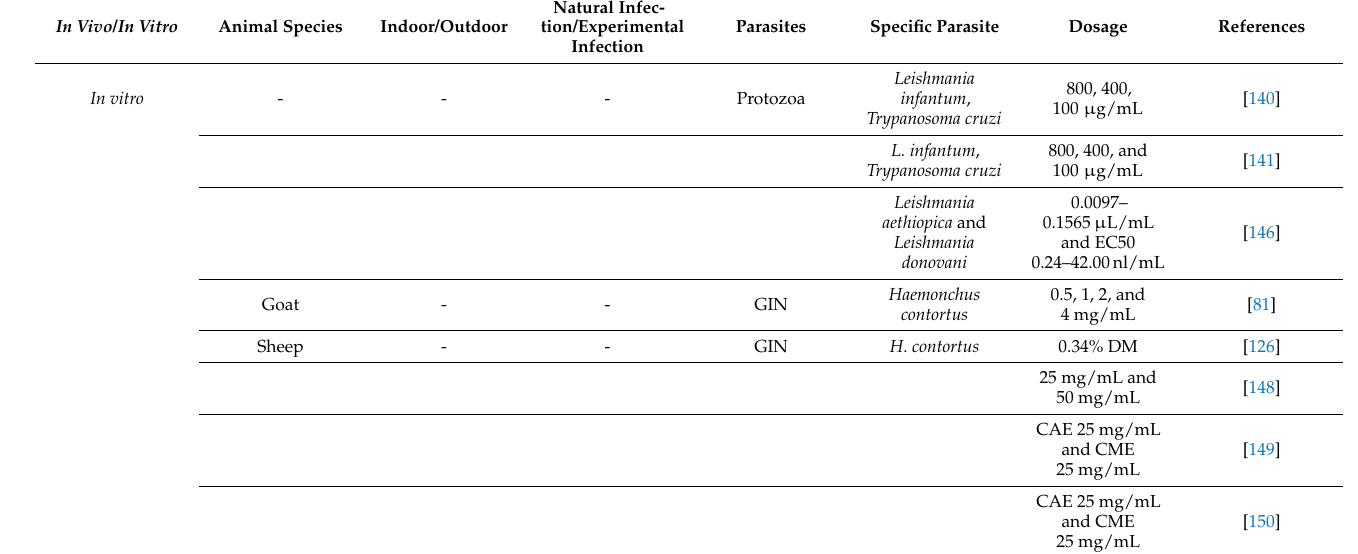
Table 1. Brief description of trials for the antiparasitic effect of Artemisia